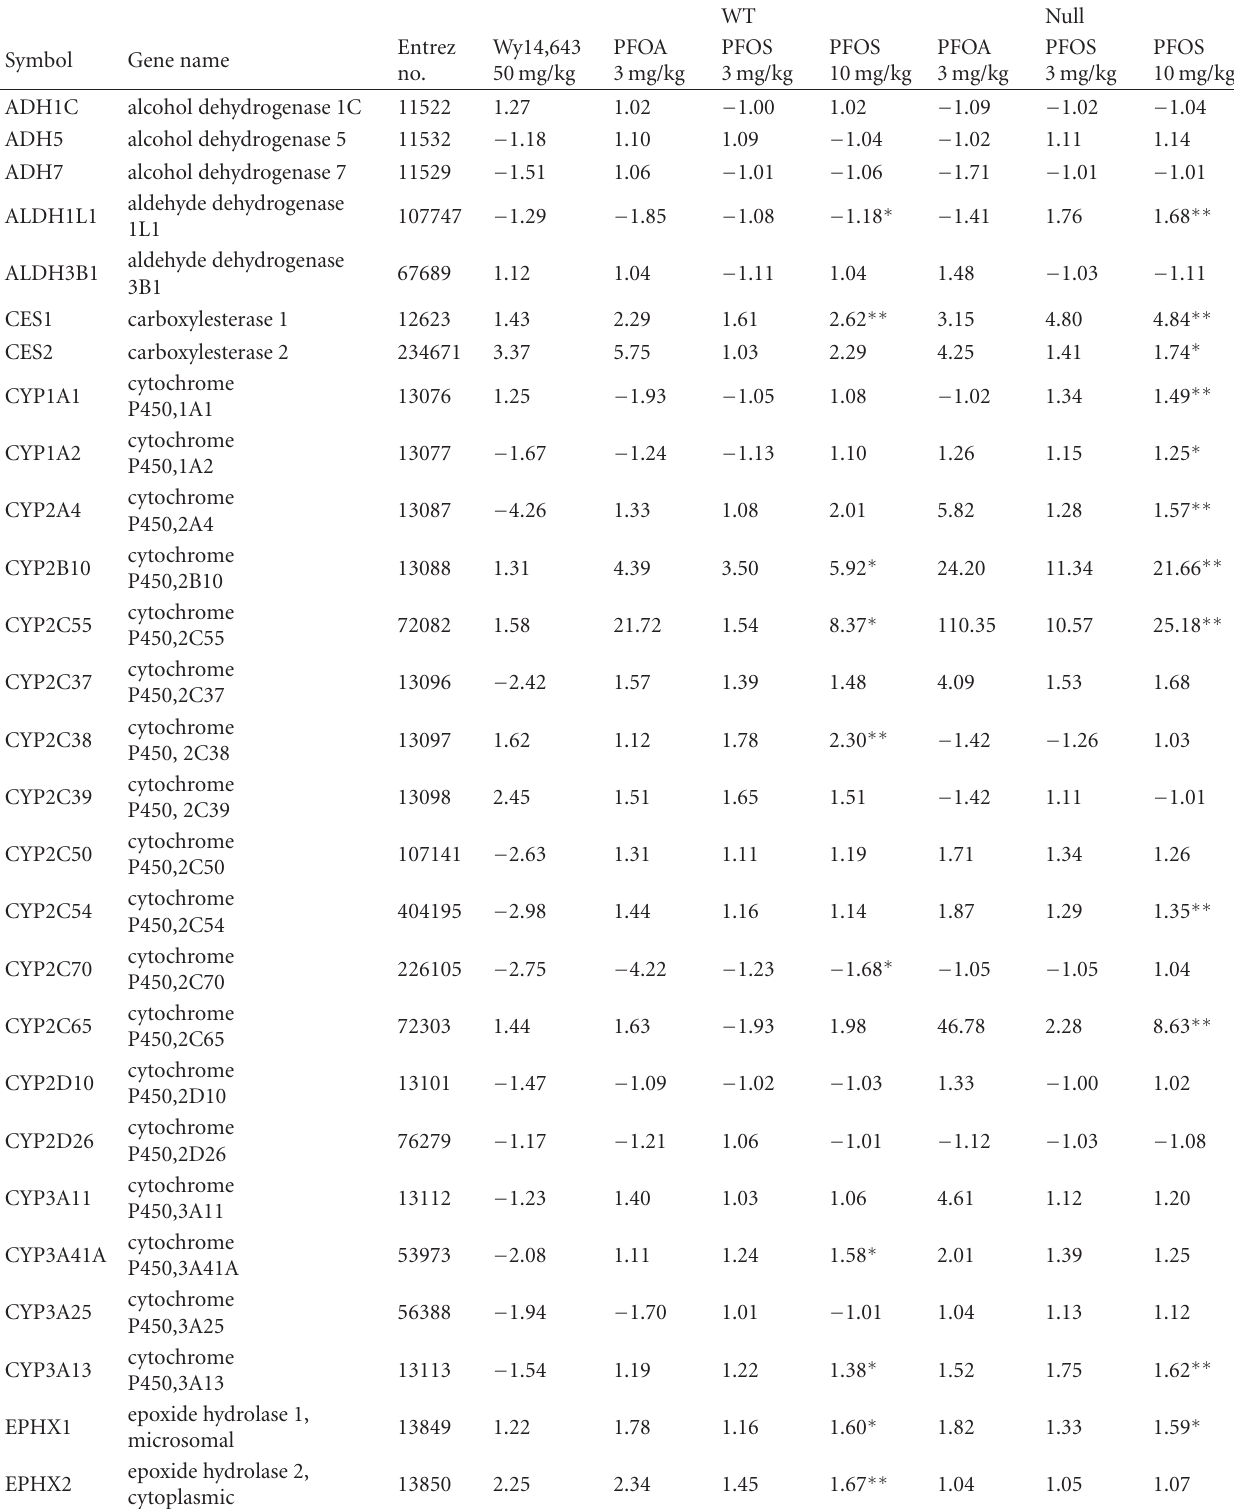
Table 7: Average fold change for genes related to xenobiotic metabolism in wild-type and PPAR α -null male mice following a seven-day exposure to Wy-14,643 1 , PFOA 1 , or PFOS.